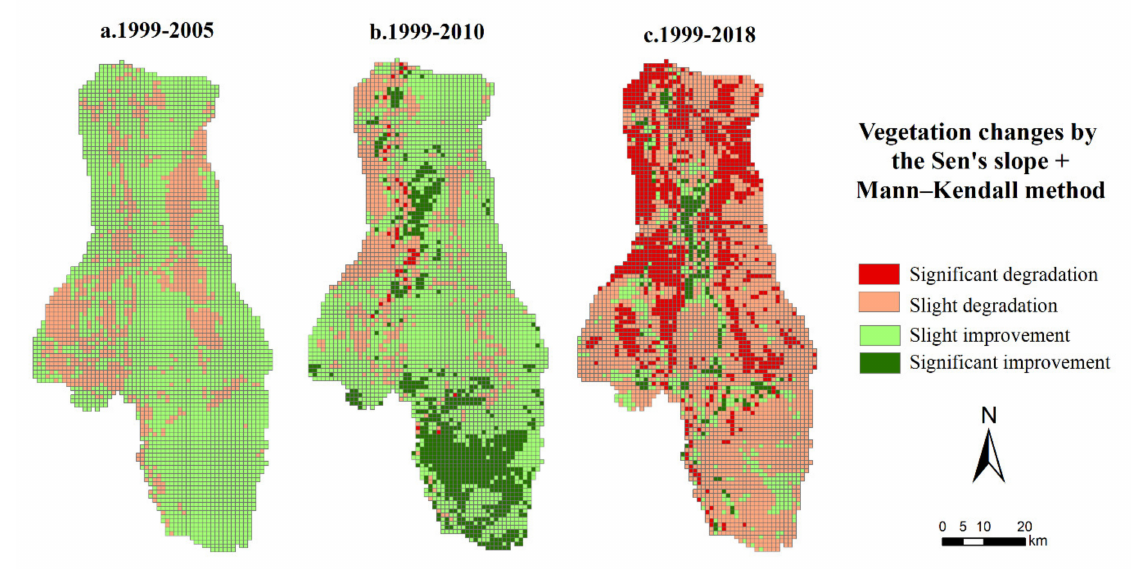
Figure 3. ( a – c ) Spatial distribution of vegetation changes by Sen’s slope and Mann–Kendall method. ( a ) 1999–2005; ( b ) 1999–2010; ( c